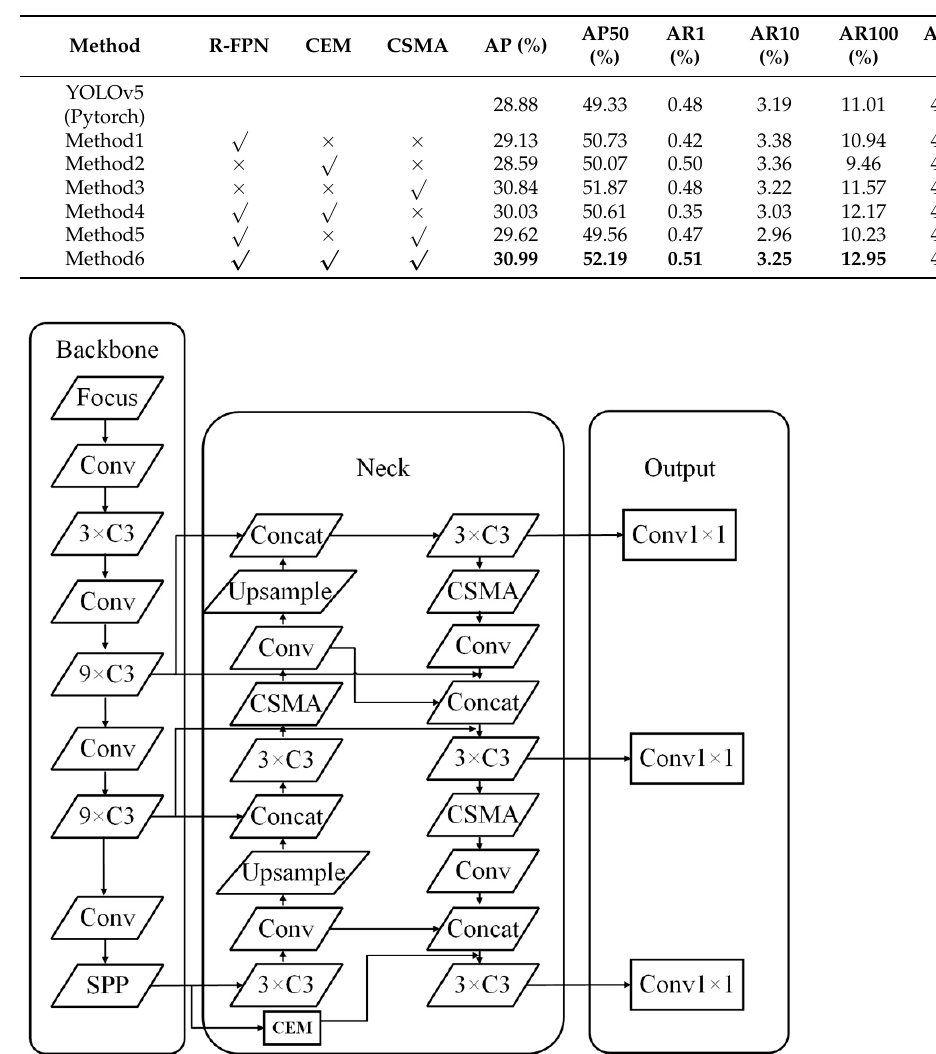
Table 3. Performance for Different Input Combinations of Refinement Network.